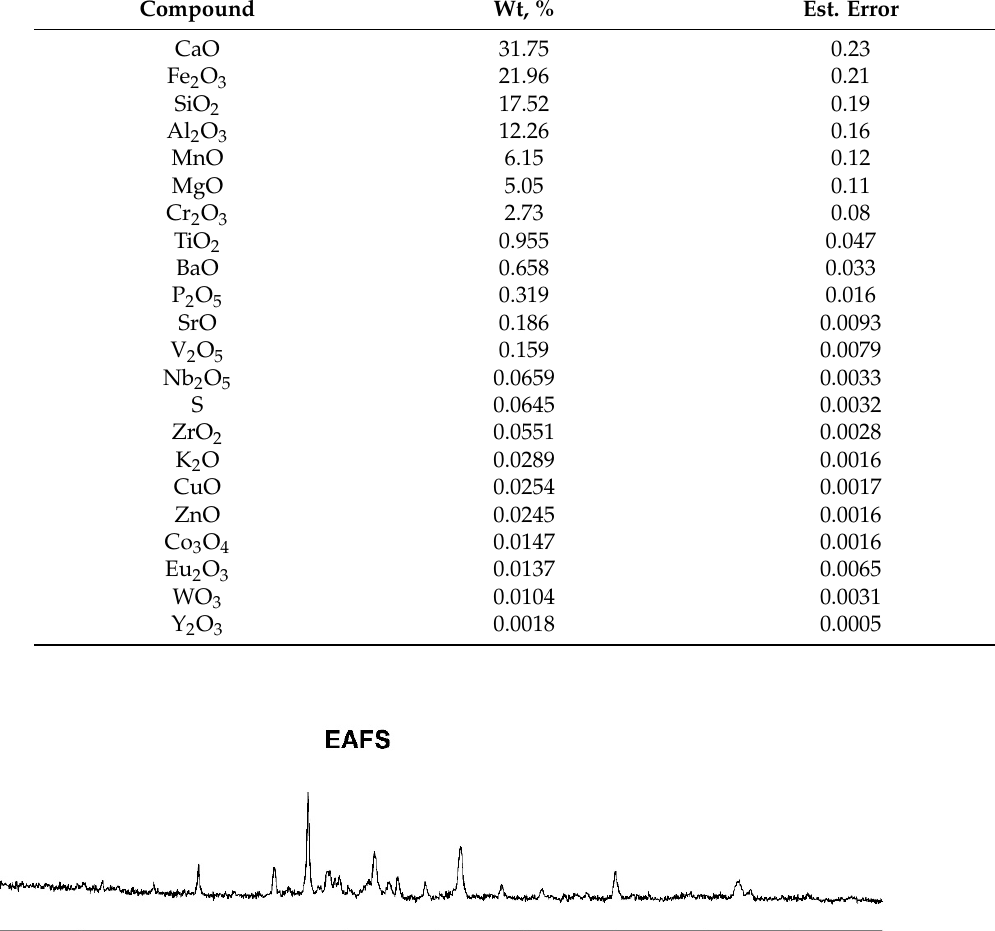
Table 8. X-ray fluorescence of electric arc furnace slag.